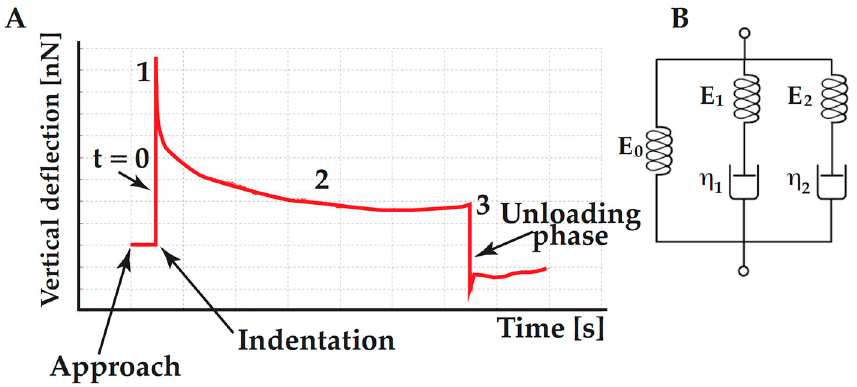
Figure 3. ( A ) Cartoon illustrating the viscoelastic test, ( B ) Generalized Maxwell model used to extract data from the viscoelastic test.